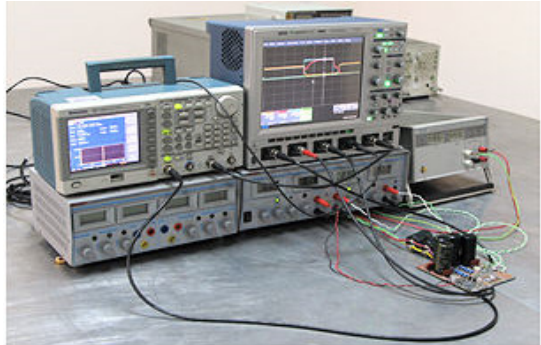
Figure 6. Measurement test-bench setup.